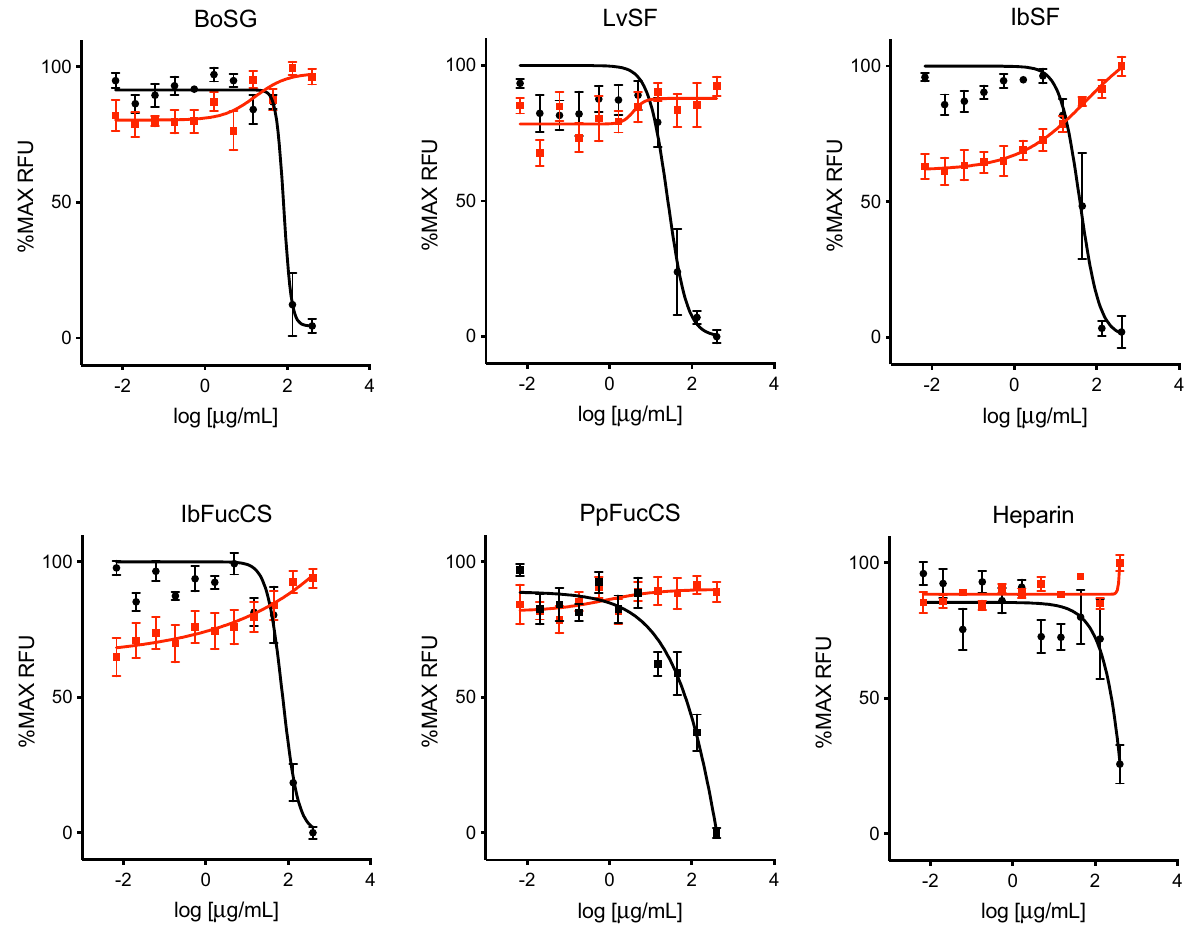
Figure 3. Antiviral activity of MSGs against MERS-CoV. Anti-MERS-CoV activity (black) and cytotoxicity (red) were measured as described in Fig. 2, except using MERS-CoV spike-pseudotyped VLPs and HeLa-DPP4